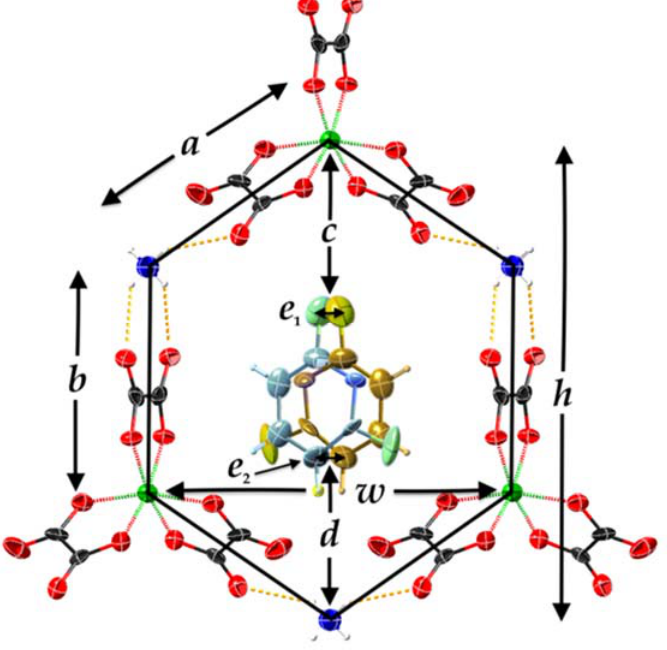
Figure 5. Scheme for the hexagonal unit dimensions and the guest molecule placement in the anion layers of salts 1 – 5 , using salt 5 as an example. Table 4. The dimensions of the anion layer hexagonal cavity and the orientation of the HalPy guest molecule as annotated in Figure 5. δ is the angle between the pyridine ring plane and the plane of the hexagonal cavity. e is a mean guest molecule displacement defined as ( e 1 + e 2 )/2, where e 1 is a displacement of the outer halopyridine halogen atom nearest to the cusp Fe 3+ ion around the twofold axis, e 2 is a displacement of the inner halopyridine ring carbon/nitrogen atom closest to the nadir nitrogen atom of NH 4 + ion. e’ is an alternative mean displacement value ( e 1 + e 2 + ... + e n )/ n where averaging is taken for all displaced atoms. S is a square unit of the hexagonal cavity taken as w ( b + h )/2.